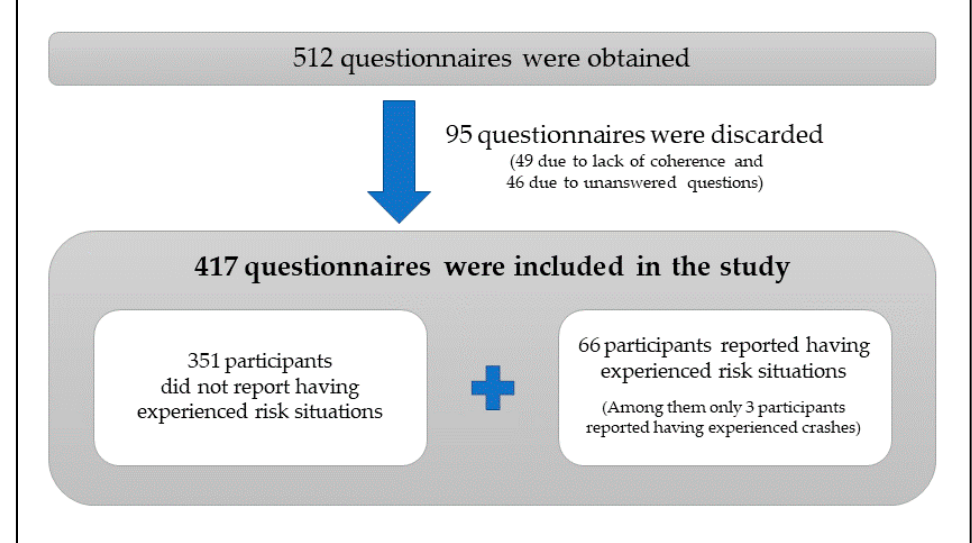
Figure 2. A nalysis process applied to the questionnaires. Figure 2. Analysis process applied to the